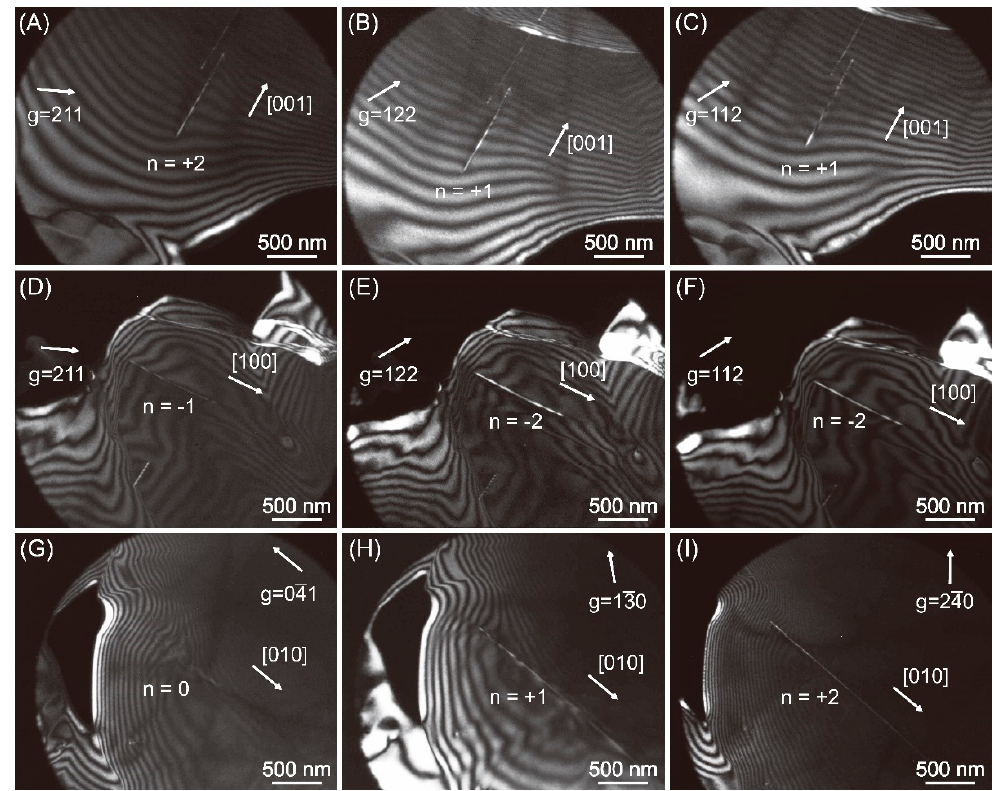
Figure 6. Representative weak-beam dark-field images showing the dislocation microstructure of olivine in three different locations from sample 447. The diffraction vectors for each image are noted as g . The white arrow and n value indicate the number of the terminating thickness fringes for each image. ( A – C ) WBDF images of the same location with three different diffraction vectors: g = 211 in ( A ), g = 122 in ( B ), and g = 112 in ( C ). ( D – F ) WBDF images of a second location/site with three different diffraction vectors: g = 211 in ( D ), g = 122 in ( E ), and g = 112 in ( F ). ( G – I ) WBDF images of a third location / site with three different diffraction vectors: g = 0 4´ 1 in ( G ), g = 1 3´ 0 in ( H ), and g = 2 4´ 0 in ( I ). Table 1. Summary of olivine slip systems determined by the thickness fringe method in samples 447 and